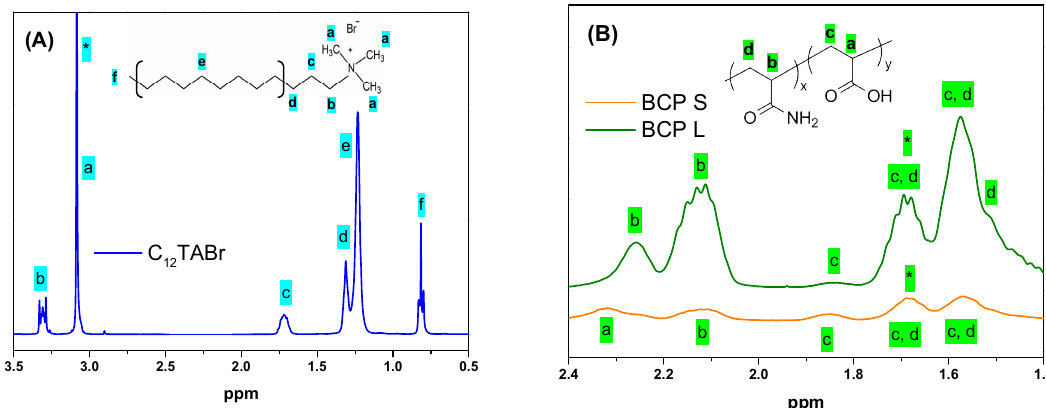
Figure 1. 1 H NMR spectra for ( A ) surfactant and ( B ) block copolymer solutions with labeled peaks according to the chemical structures presented in the inset. The peaks used for diffusion experiments are indicated with asterisks. The terms S and L refer to the length of the PAAm block in the BCP (short and long, respectively). Solutions contain the individual components (surfactants and block copolymers) at a charge concentration of 25 mM, which is above the cmc for the surfactant. Note in ( B ) that since the PA concentration was the nearly the same for the two block copolymer solutions, the intensities of all of the PAAm peaks are much stronger for PAAm 432 - b -PAA 70 (BCP L) than they are for PAAm 133 - b -PAA 49 (BCP S).